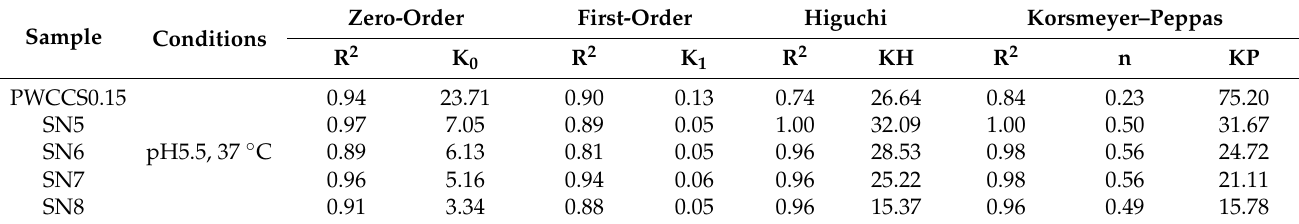
Table 3. Kinetic model prediction of anthocyanin releasing from 7sericin hydrogels (SN5–SN8) and 0.15% PWCC